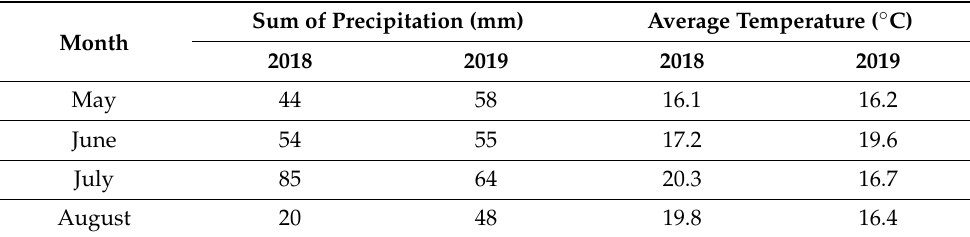
Table 1. Agroclimatic conditions of field experiments in